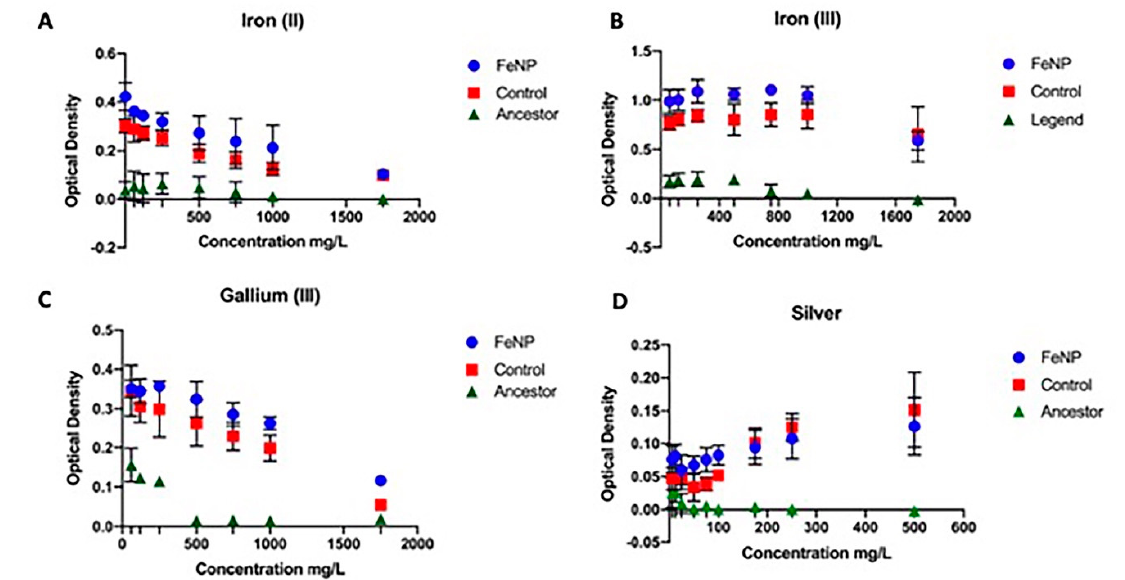
Figure 2. The mean and SE of 24 h growth for FeNP, Control, and Ancestral populations in increasing concentration of metals are shown. The FeNP populations showed superior growth compared to controls for iron (II, III, A , B ) and gallium (III, C ) from 6–1750 mg/L. For silver superiority was shown from 6–100 mg/L ( D ). The ancestor showed inferior growth to the FeNPs and controls at all concentrations.